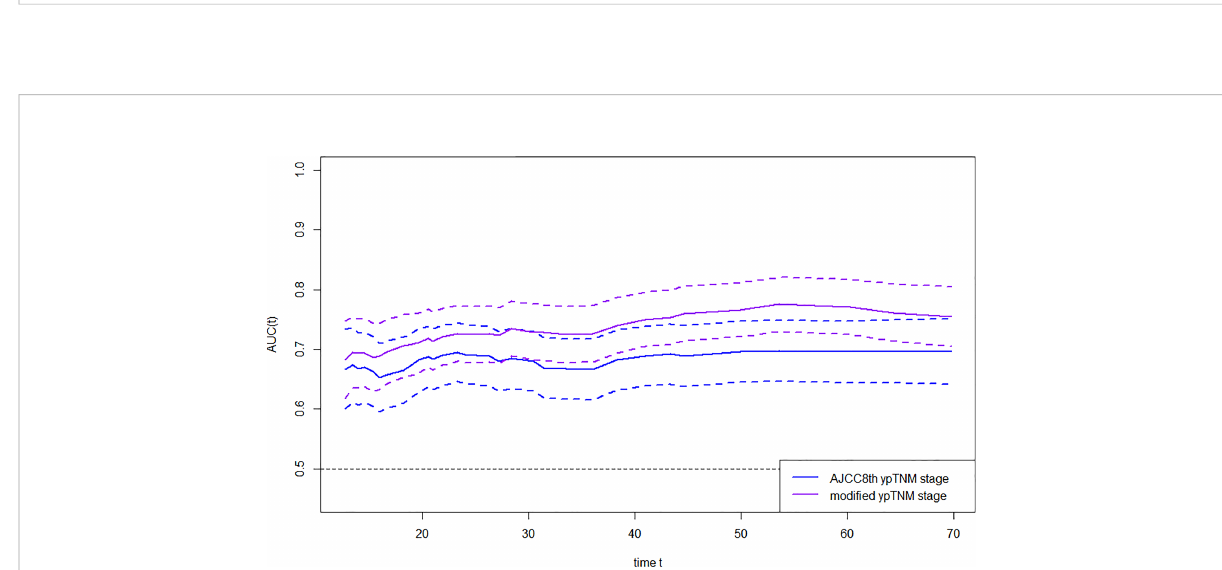
FIGURE 3 AUC of AJCC eighth and modi fi ed ypTNM stage in time-dependent ROC.